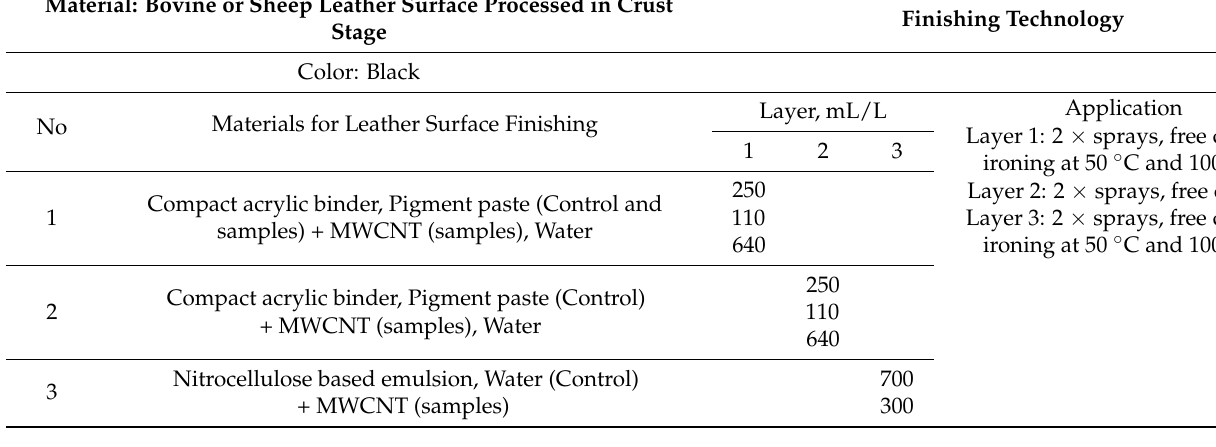
Table 1. Leather finishing technology for functionalization with MWCNTs.